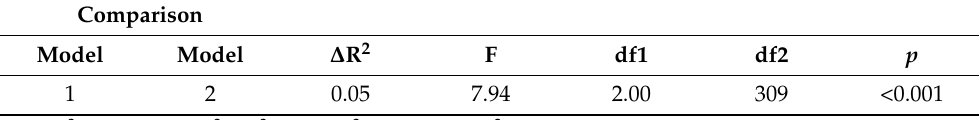
Table 10. Model Comparison for Depersonalisation.